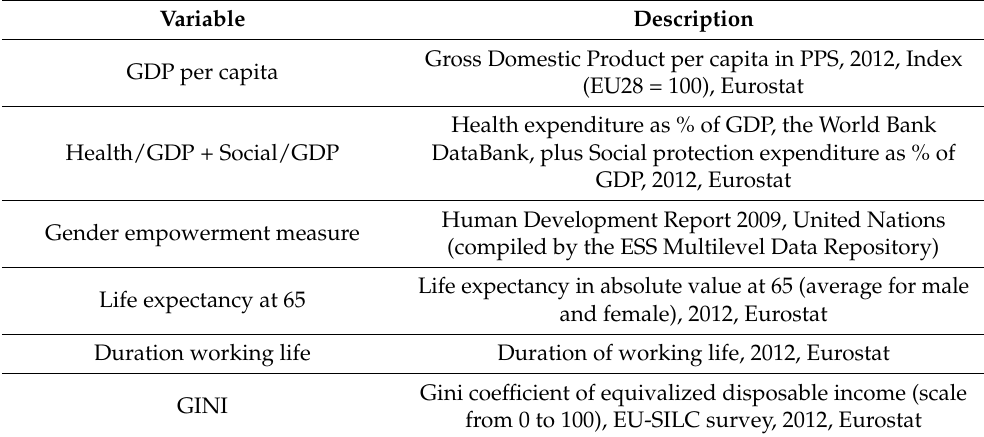
Table A2. Variables used in factor analyses of welfare